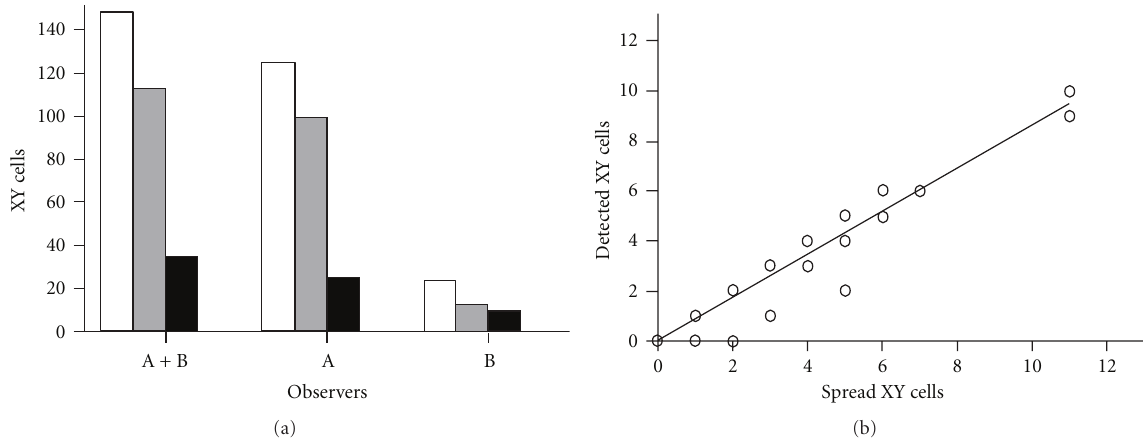
Figure 3: Comparison between detected cells and the true number of XY cells. (a) Summary of true (white bars), detected (grey bars) and missed (black bars) cells reported for observer A and observer B. (b) Regression analysis represents the correlation between these data.